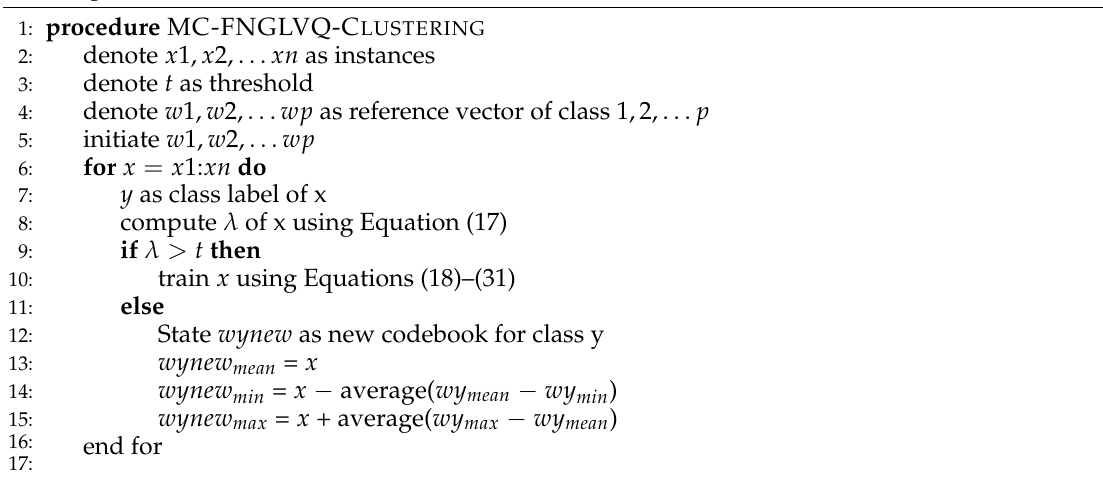
Algorithm 2 Multi Codebook Fuzzy Neuro Generalized Vector Quantization Using Incremental Learning.